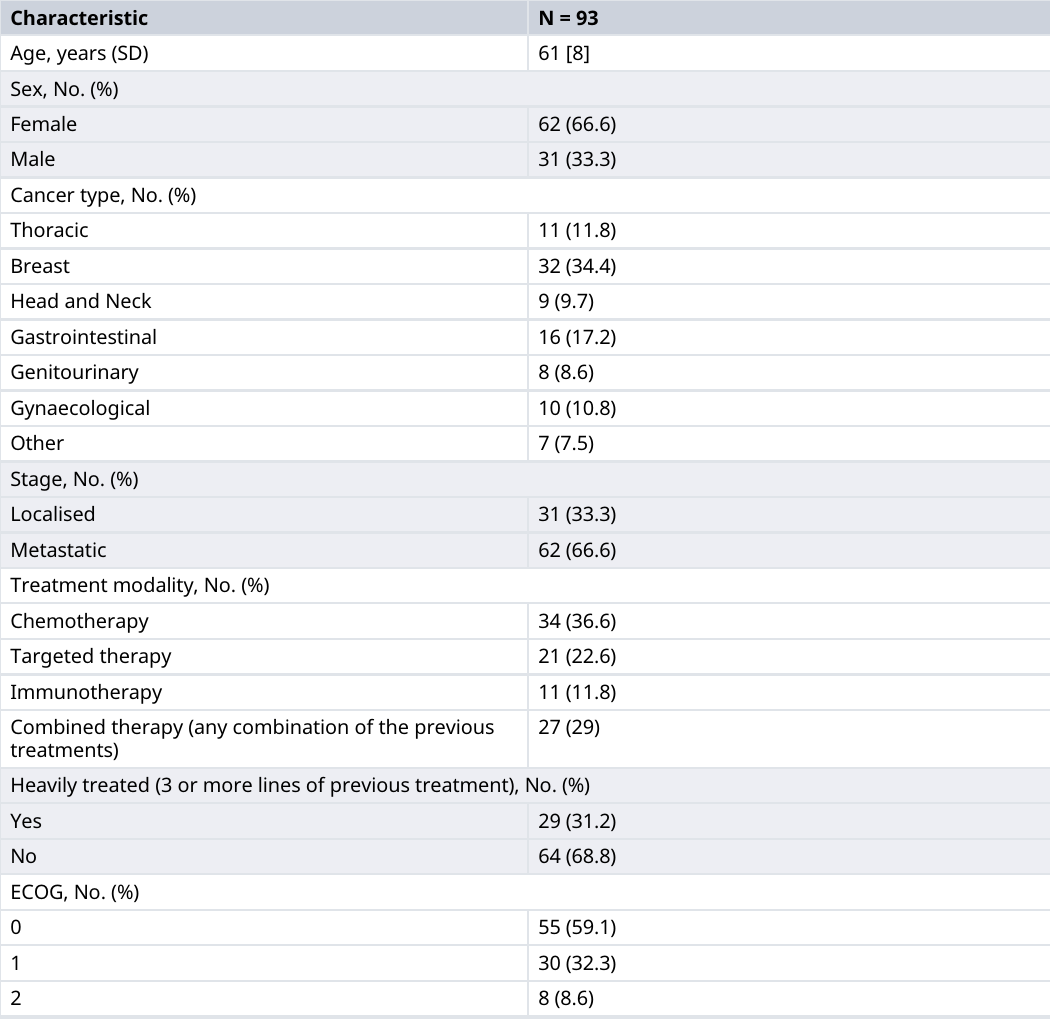
Table 1. Demographic, cancer, and therapy characteristics of the patients. Characteristic